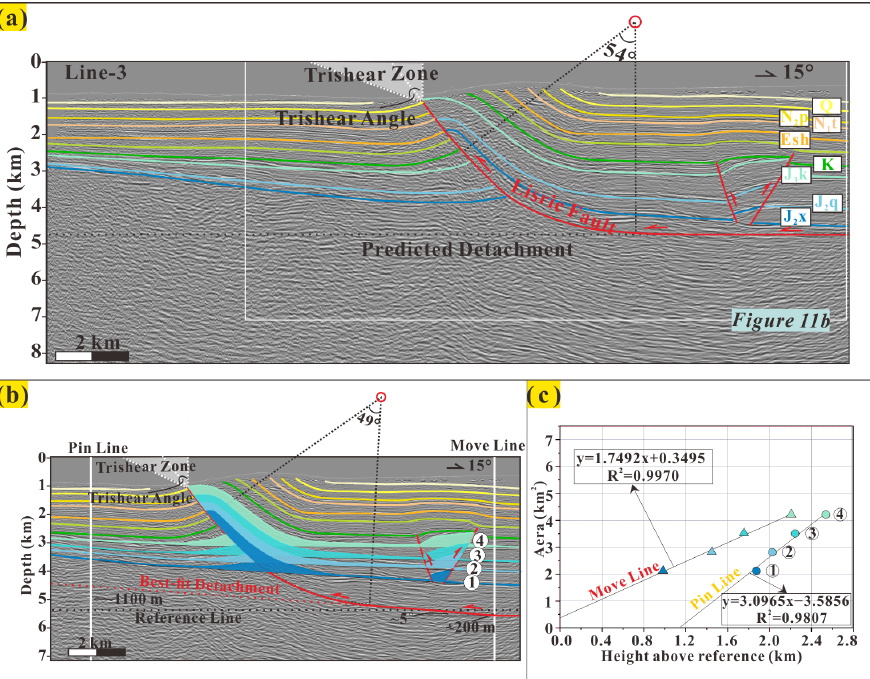
Figure 10. Seismic interpretation and ADS analysis of Line 2 (location in Figure 2a). ( a ) Interpretations of the seismic reflection profile. Vertical exaggeration is 1:1. ( b ) Areas and heights measured for horizons 1–4. ( c ) Area-depth diagram illustrating the area-depth relationships on both move lines and pin lines, with R 2 values of >0.98.